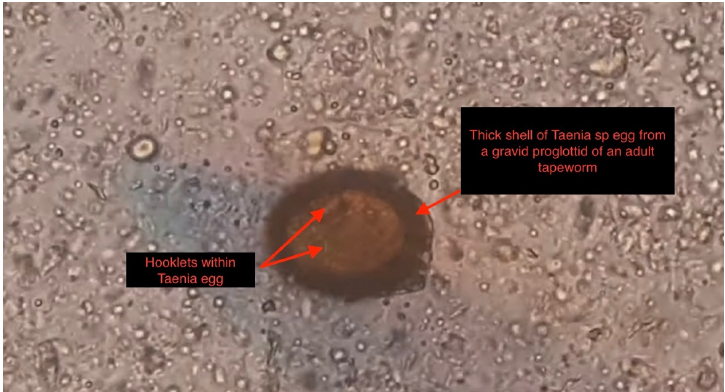
Figure 1. Microscopic slide view (magnified 1600×), Showing a thick wall egg shed from a gravid proglottid of a Taenia sp. containing embryo hooklets (red arrows in slide) in the stool sample of our patient three months following symptoms onset. Table 1. Patient CSF analysis showing moderate pleocytosis with eosinophilia, and slight increase in protein.